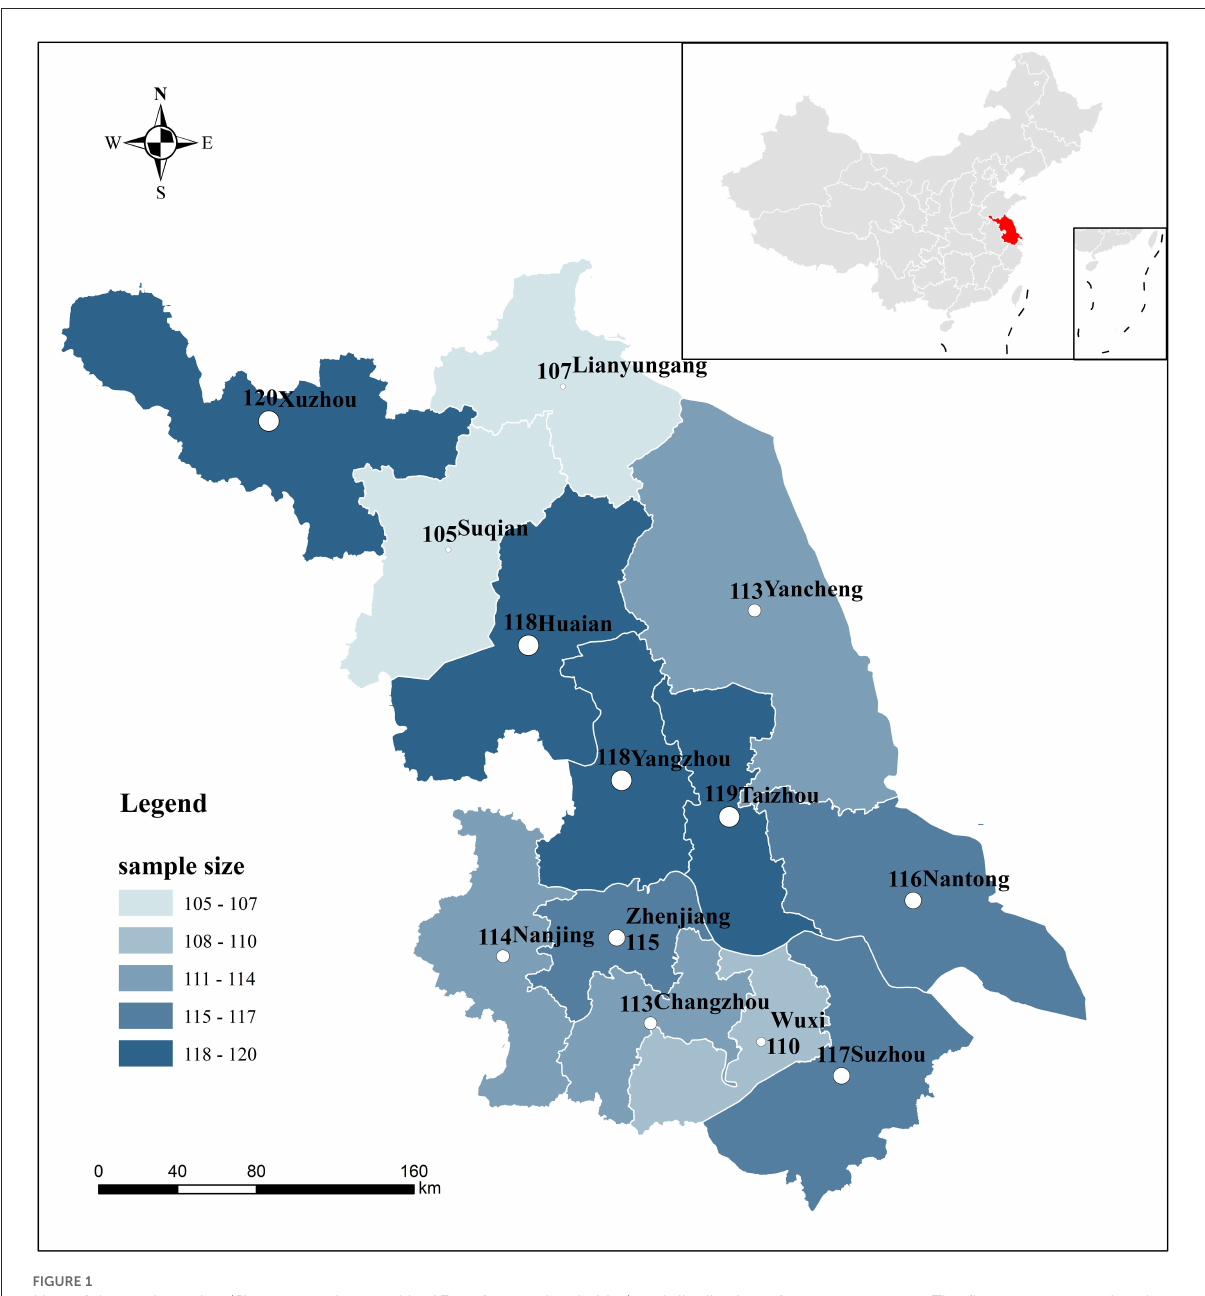
as most community emergency staff preferred not to be